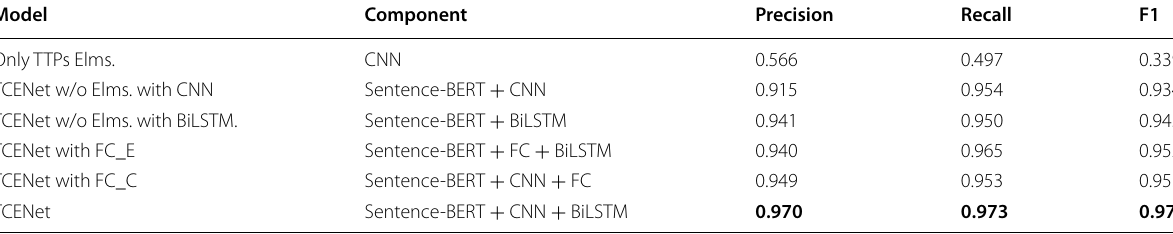
The best result is noted in bold font